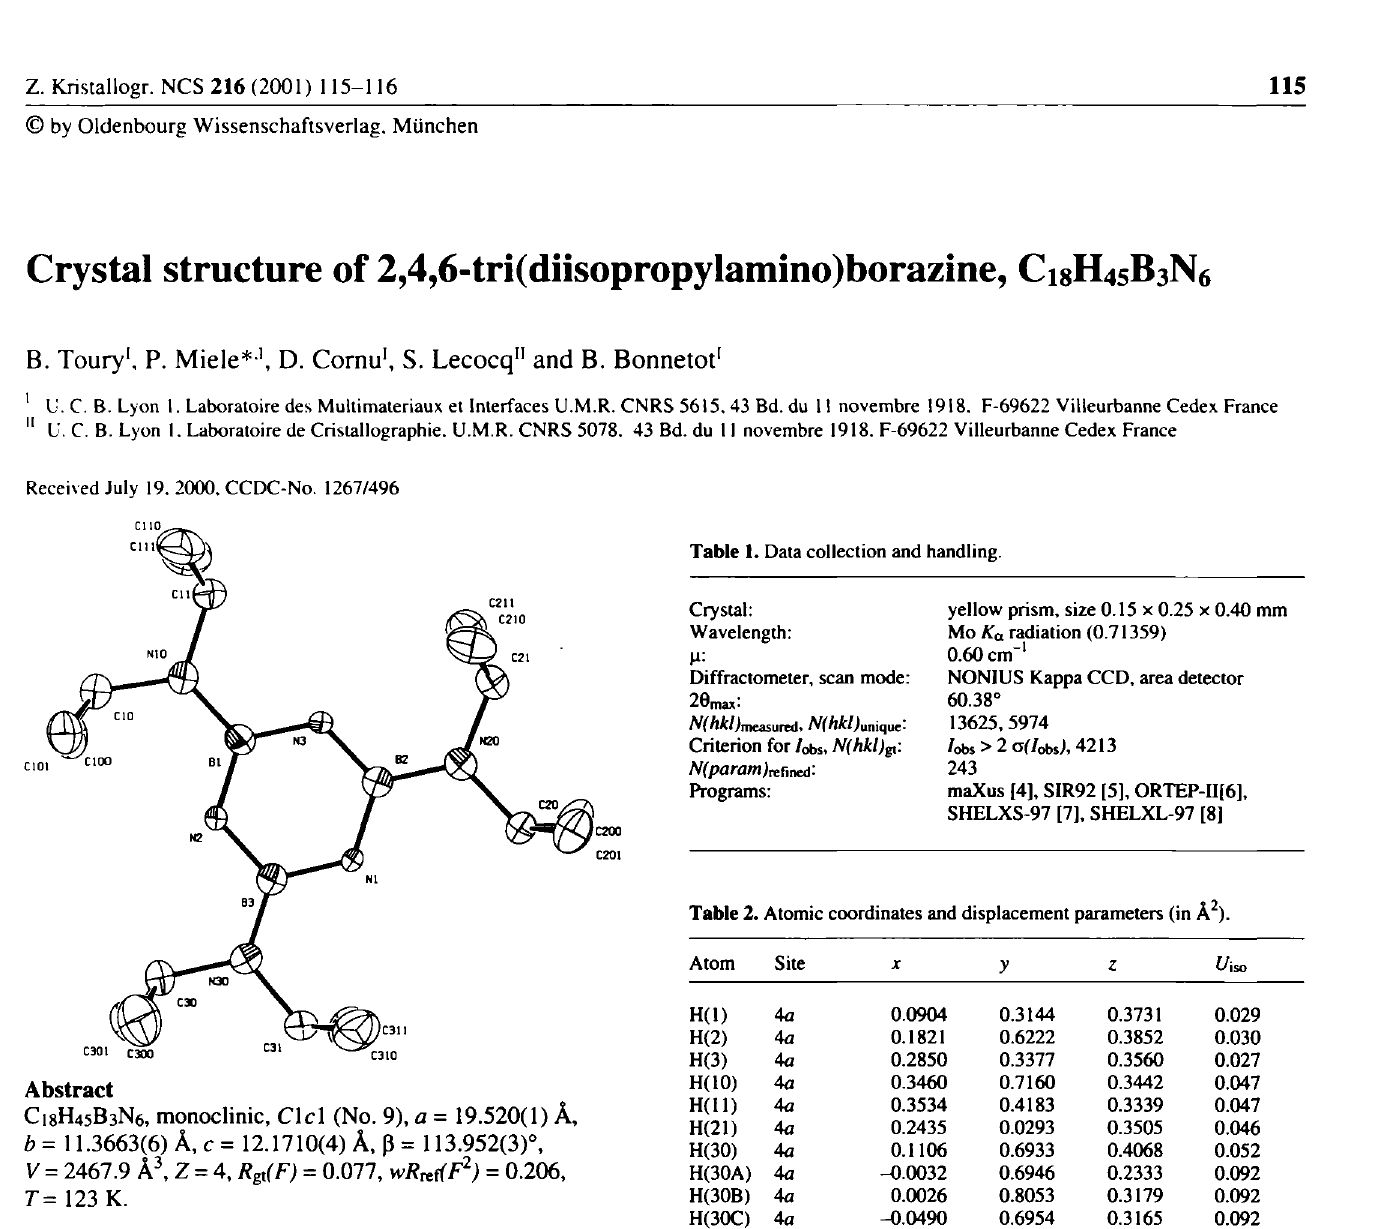
Table 2. Atomic coordinates and displacement parameters (in Ä 2